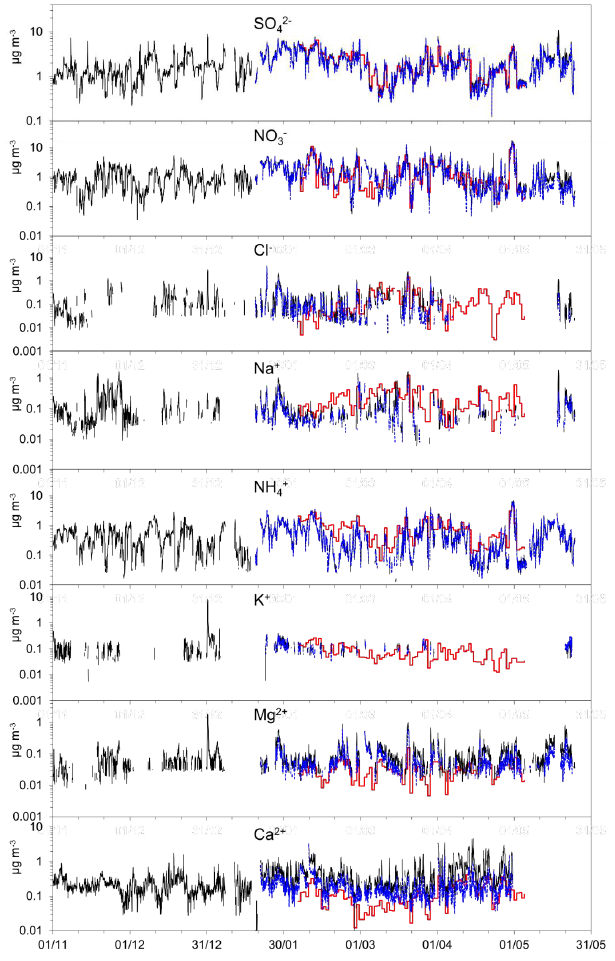
Fig. 1. Hourly-averaged concentrations of inorganic ions in aerosols at SMEAR III from 1 November 2009 to 25 May 2010. MARGA data in PM 10 (black line) and PM 2 . 5 (blue line); concentrations ana- lyzed from 24-h PM 10 filter samples (red line). Note: before 19 Jan- uary 2010, there was only a total aerosol inlet in use and no PM 2 . 5 cyclone.